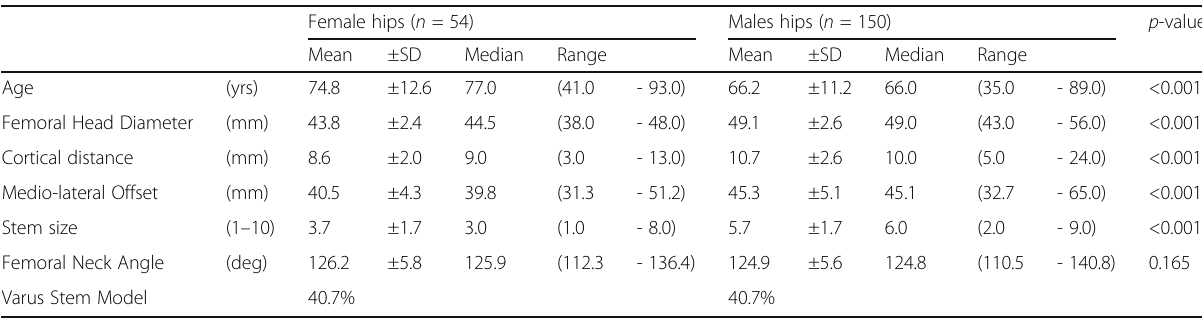
Table 1 Demographics and dimensions by